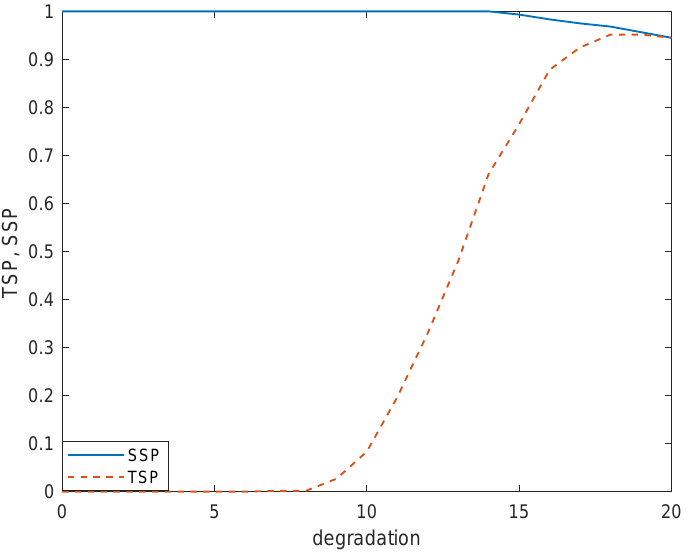
Figure 2. TSP and SSP under single task